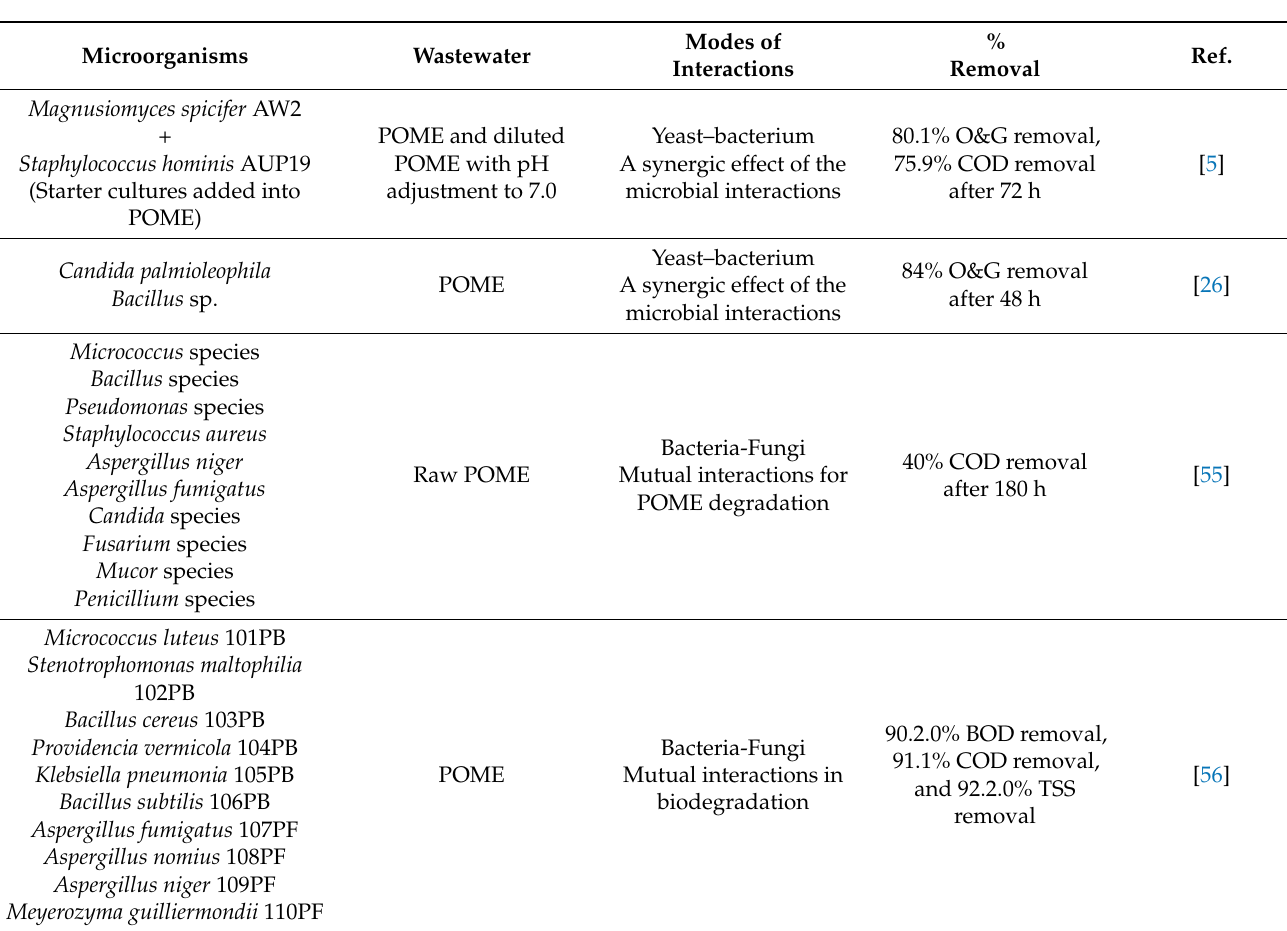
Table 7. Co-culture and microbial cells application for wastewater